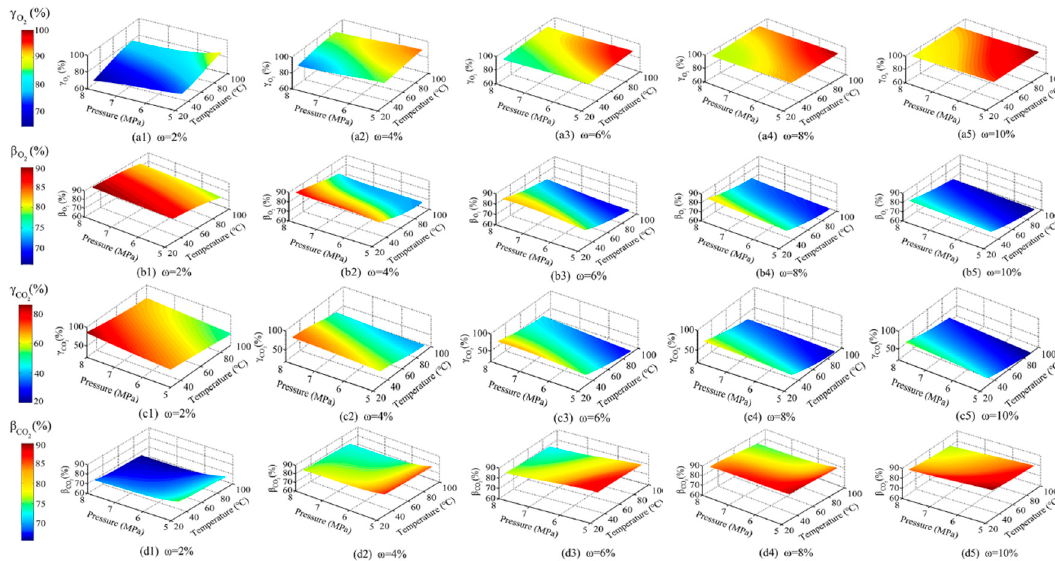
Figure 7. The effect of feed concentration on the performance of the high-pressure and low-pressure separator, ( a1 ) γ O2 at ω = 2 wt%, ( a2 ) γ O2 at ω = 4 wt%, ( a3 ) γ O2 at ω = 6 wt%, ( a4 ) γ O2 at ω = 8 wt%, ( a5 ) γ O2 at ω = 10 wt%, ( b1 ) β O2 at ω = 2 wt%, ( b2 ) β O2 at ω = 4 wt%, ( b3 ) β O2 at ω = 6 wt%, ( b4 ) β O2 at ω = 8 wt%, ( b5 ) β O2 at ω = 10 wt%, ( c1 ) γ CO2 at ω = 2 wt%, ( c2 ) γ CO2 at ω = 4 wt%, ( c3 ) γ CO2 at ω = 6 wt%, ( c4 ) γ CO2 at ω = 8 wt%, ( cd ) γ CO2 at ω = 10 wt%, ( d1 ) β CO2 at ω = 2 wt%, ( d2 ) β CO2 at ω = 4 wt%, ( d3 ) β CO2 at ω = 6 wt%, ( d4 ) β CO2 at ω = 8 wt%, and ( d5 ) β CO2 at ω = 10 wt%.